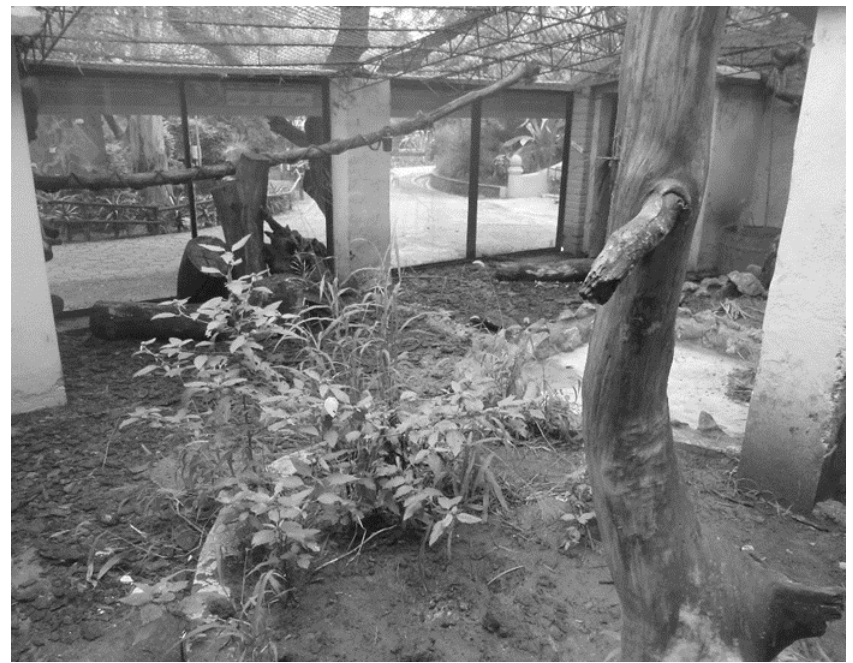
Figure 1. Housing of adult lesser anteaters ( Tamandua tetradactyla ) at Biodiversity Park. Enclosures were under natural conditions of photoperiod, temperature and humidity. Image shows the view from the rear of enclosure 2.